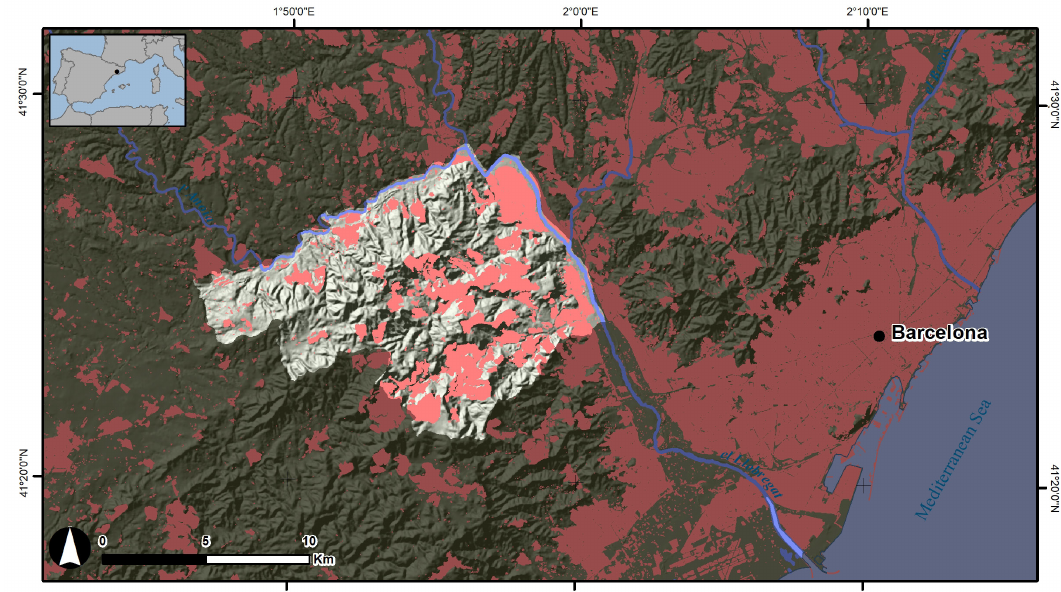
Figure 3: Location of Muntanyes d’Ordal, where the renewed ABC method was performed. Note: built up areas are depicted in pink colour.